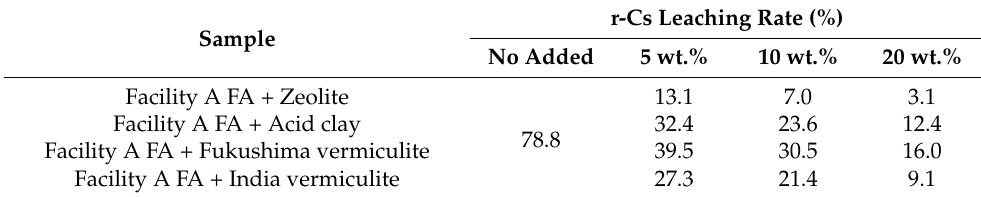
Table 7. Changes in radioactive cesium (r-Cs) leaching rate according to wt.% of clay minerals (fly ash, FA).